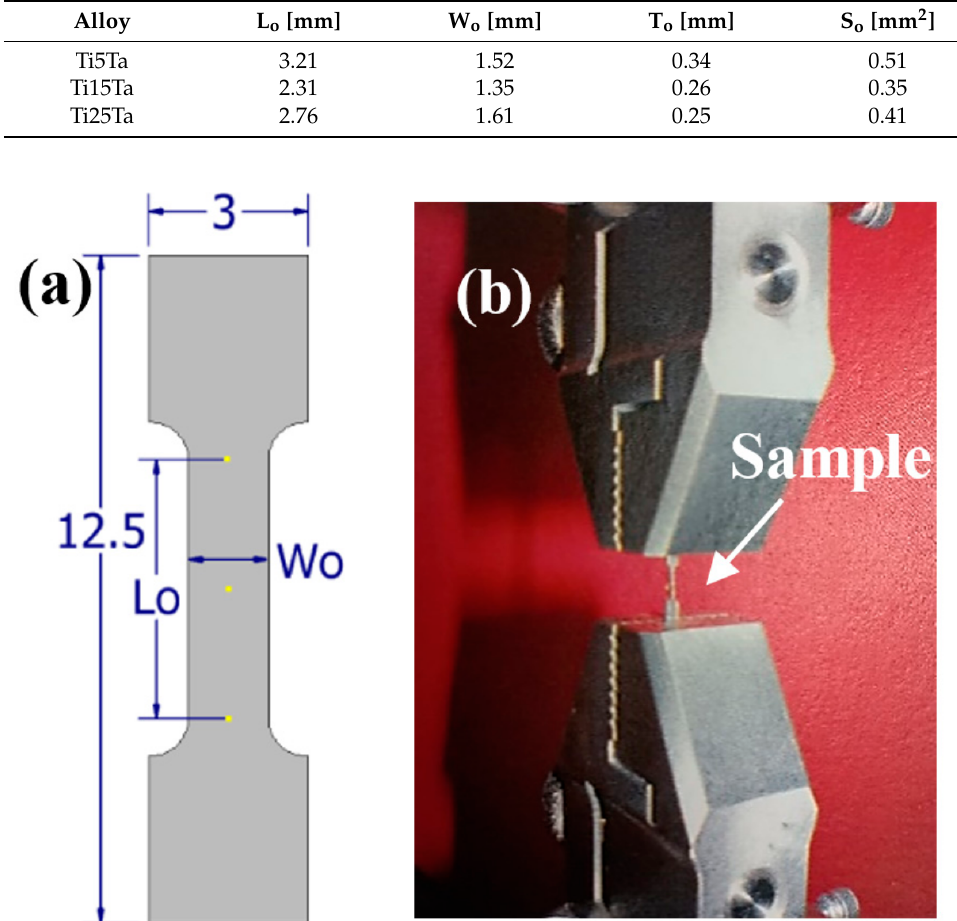
Figure 1. Schematic of tensile test specimens ( a ) and dog-bone-shaped sample fixed in the tensile testing machine ( b